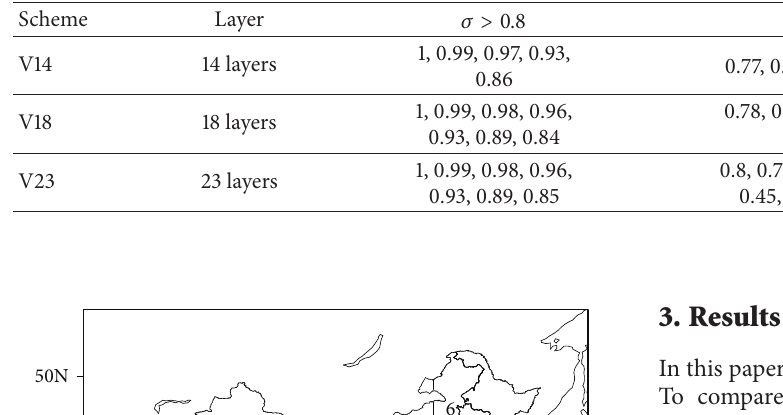
Table 2: Designed experimental schemes based on different vertical layers with different sigma ( 𝜎 ) values.